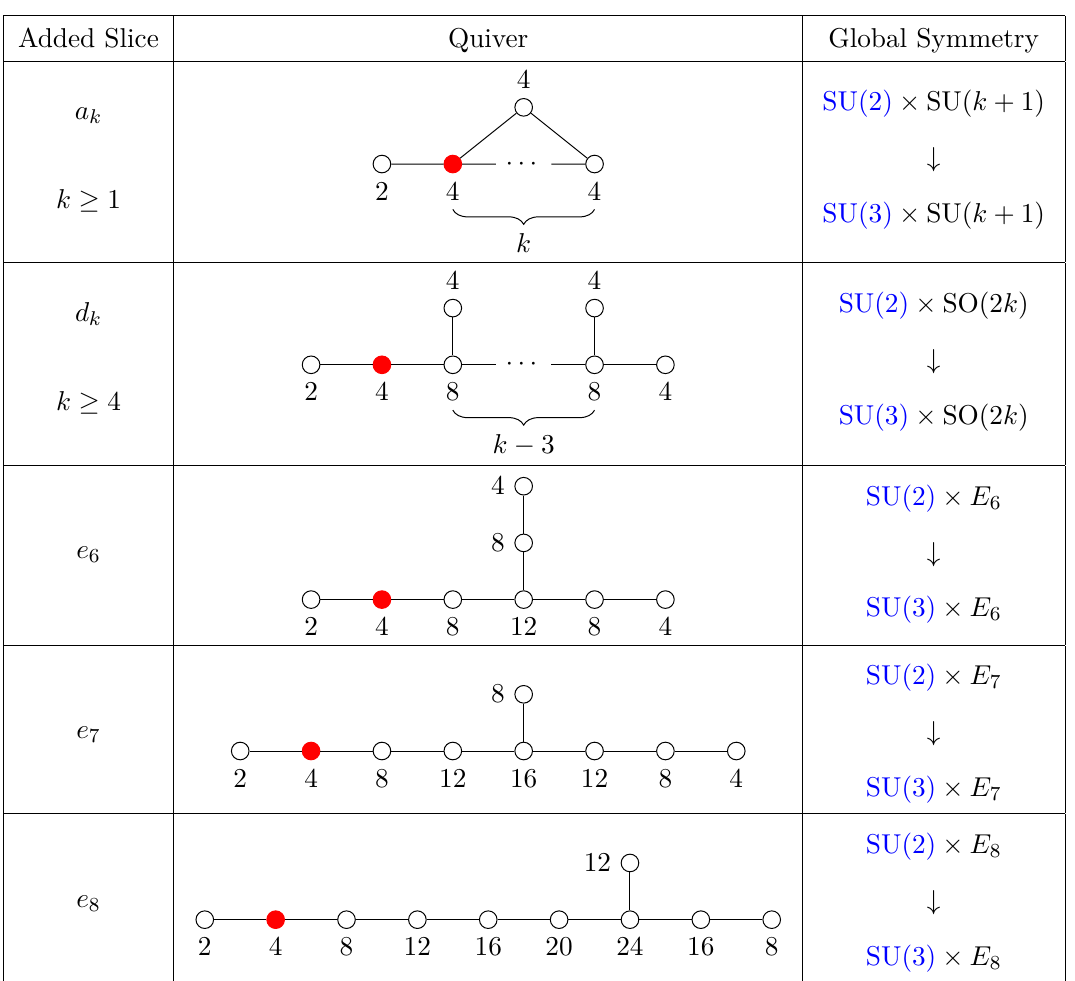
Table 20 . Quivers resulting from adding all possible simply laced elementary slices to (7.1) to absorb a